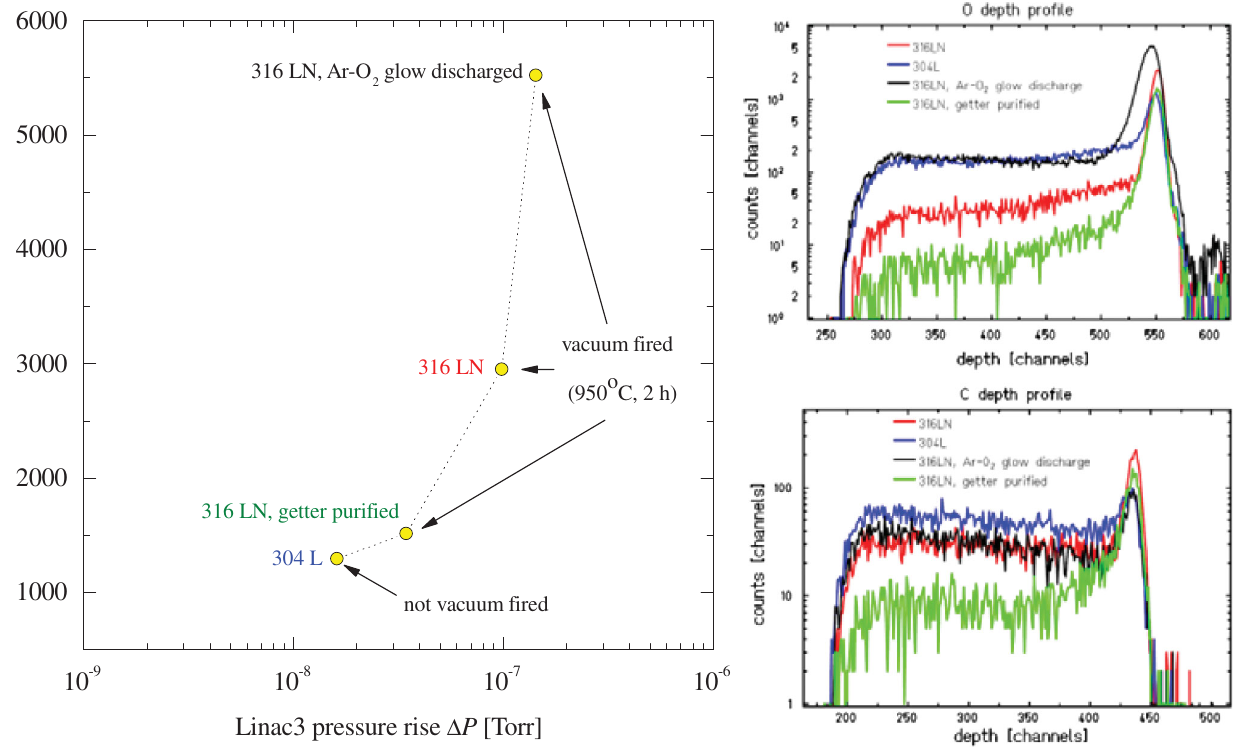
FIG. 3. (Color) Left: LINAC 3 pressure rises versus oxygen and carbon content of test samples analyzed with ERDA, the spectra are shown on the right side. Desorption measurements were done with 4 : 2 MeV = u lead ions at CERN, then the 4 vacuum chambers were cut and samples studied with ERDA at the Munich Tandem Accelerator using 1 MeV = u Au þ 30 ions